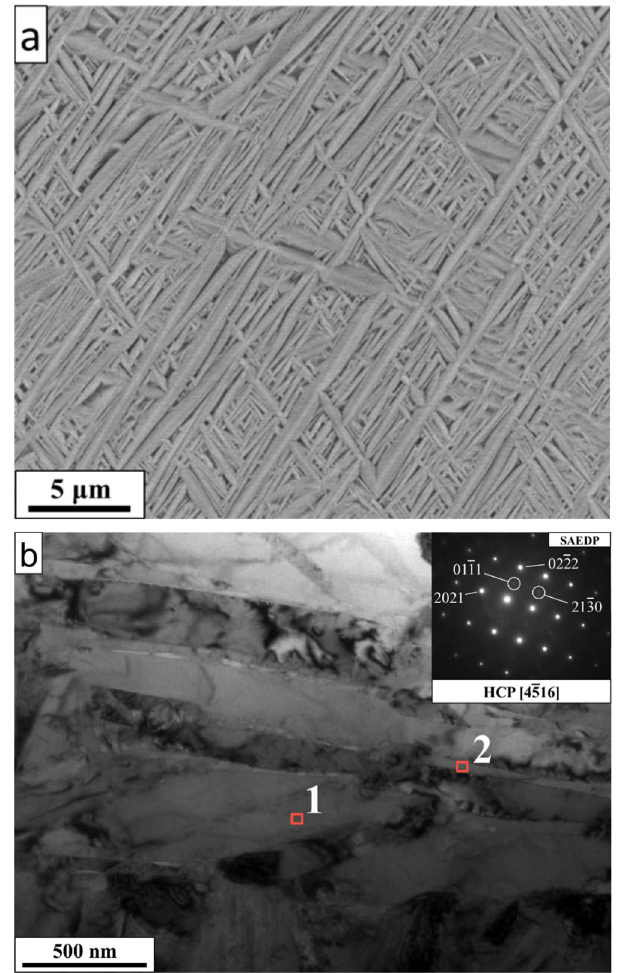
Figure 5. Microstructure of the Al 15 Hf 25 Sc 10 Ti 25 Zr 25 at.% HEA in the as-cast state; ( a ) SEM image, ( b ) TEM-BF with SAED patterns and EDS point analysis taken at the red squares, with the results given in Table 3.